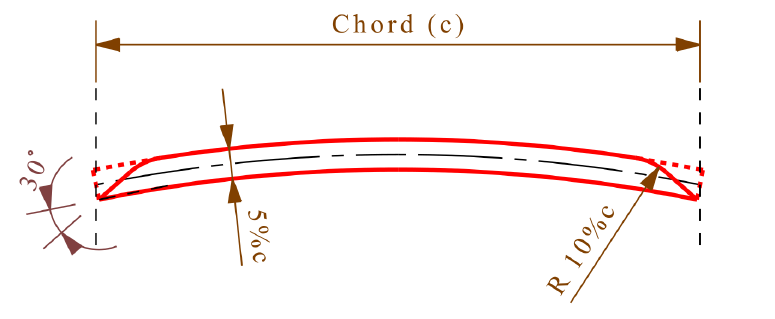
Figure 1. Airfoil geometry used in the miniature wind turbine WiRE-01. Adapted from